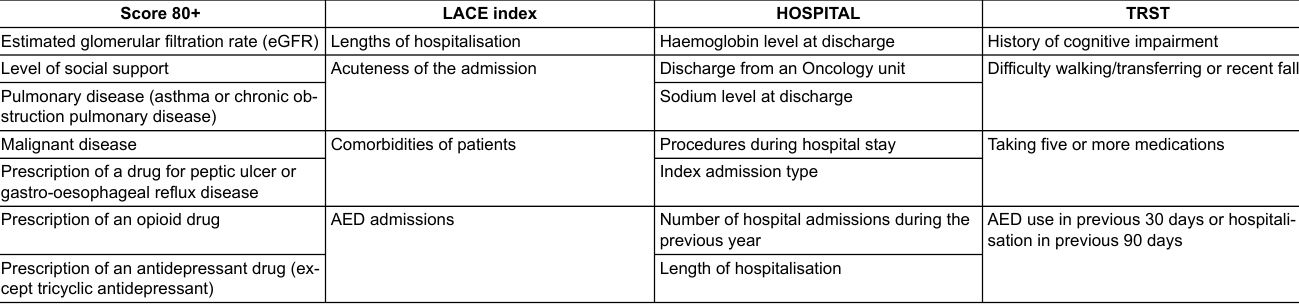
Table 1: Items comprising each of the four